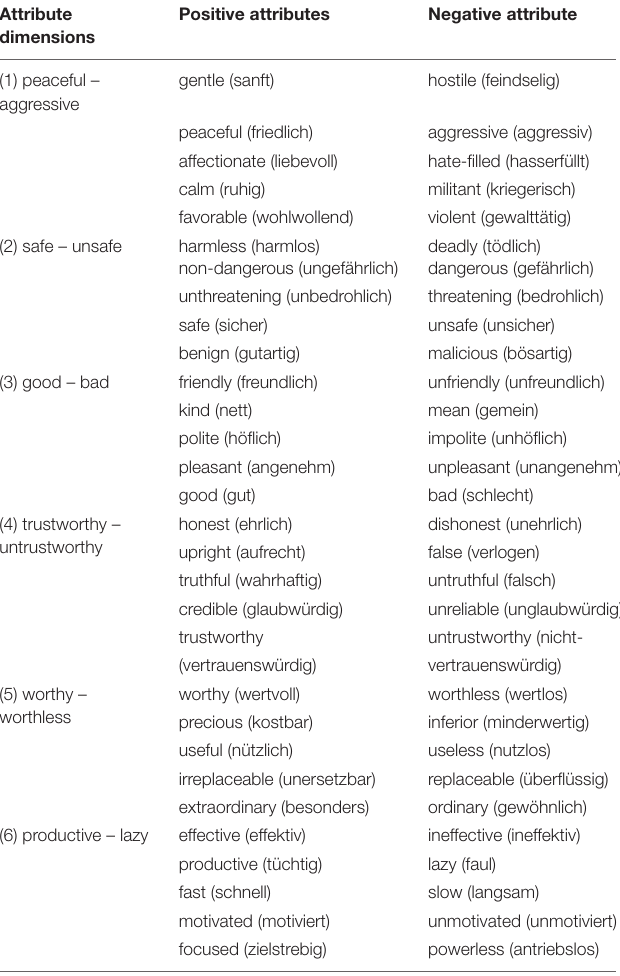
TABLE 4 | Attribute dimensions and attributes used in the md-IAT with original German wording in parentheses (Study 2). Attribute dimensions